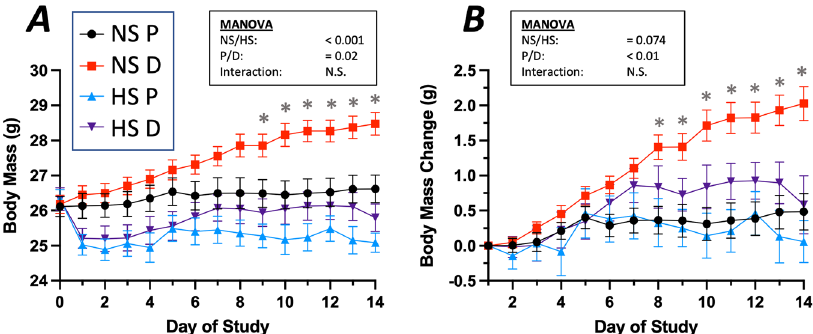
Fig. 1 Body mass. A Average body mass of mice measured daily throughout the hindlimb suspension 2-week period of time. Hindlimb suspension caused a sharp drop in body mass starting 1 day after suspension compared to control mice (NS-P). Myostatin inhibition resulted in steady increases in body mass of non-suspended mice (NS-D), which became signi fi cantly greater based on Tukey ’ s posthoc analysis starting on Day 9. B Data are presented as a change in body mass relative to hindlimb suspension Day 1 to illustrate ongoing treatment effects after the initial loss of body mass due to hindlimb suspension. The repeated measures ANOVA revealed no signi fi cant effect of hindlimb suspension over this period of time but did demonstrate a signi fi cant impact of myostatin inhibition, particularly observed in the control mice (NS-D vs. NS-P). * denotes signi fi cant difference with Tukey ’ s posthoc analysis at α = 0.05. Data are presented as mean ± SEM, n = 18